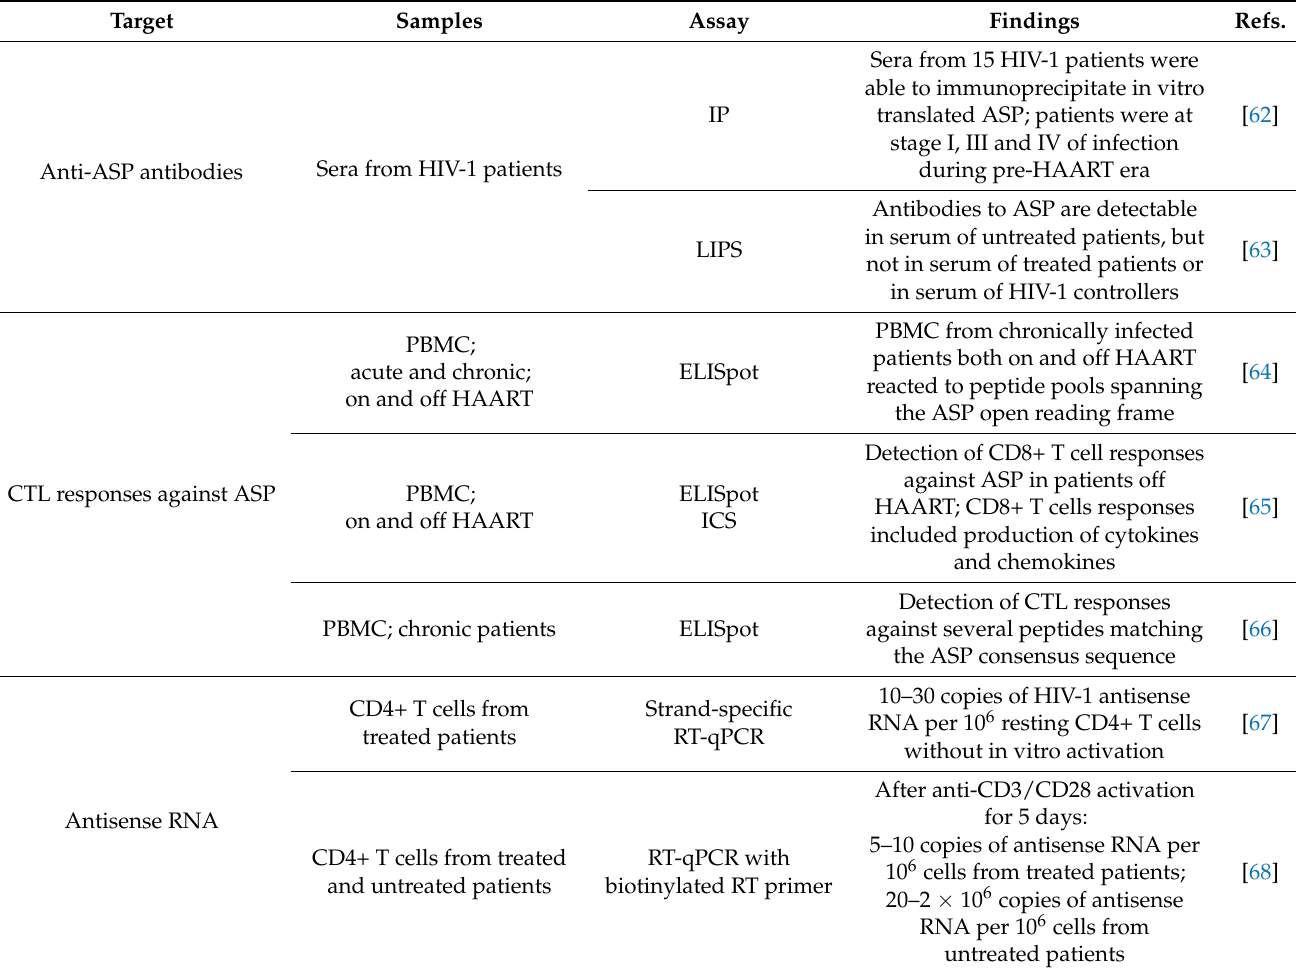
Table 1. Evidence of ASP expression in HIV-1 infected